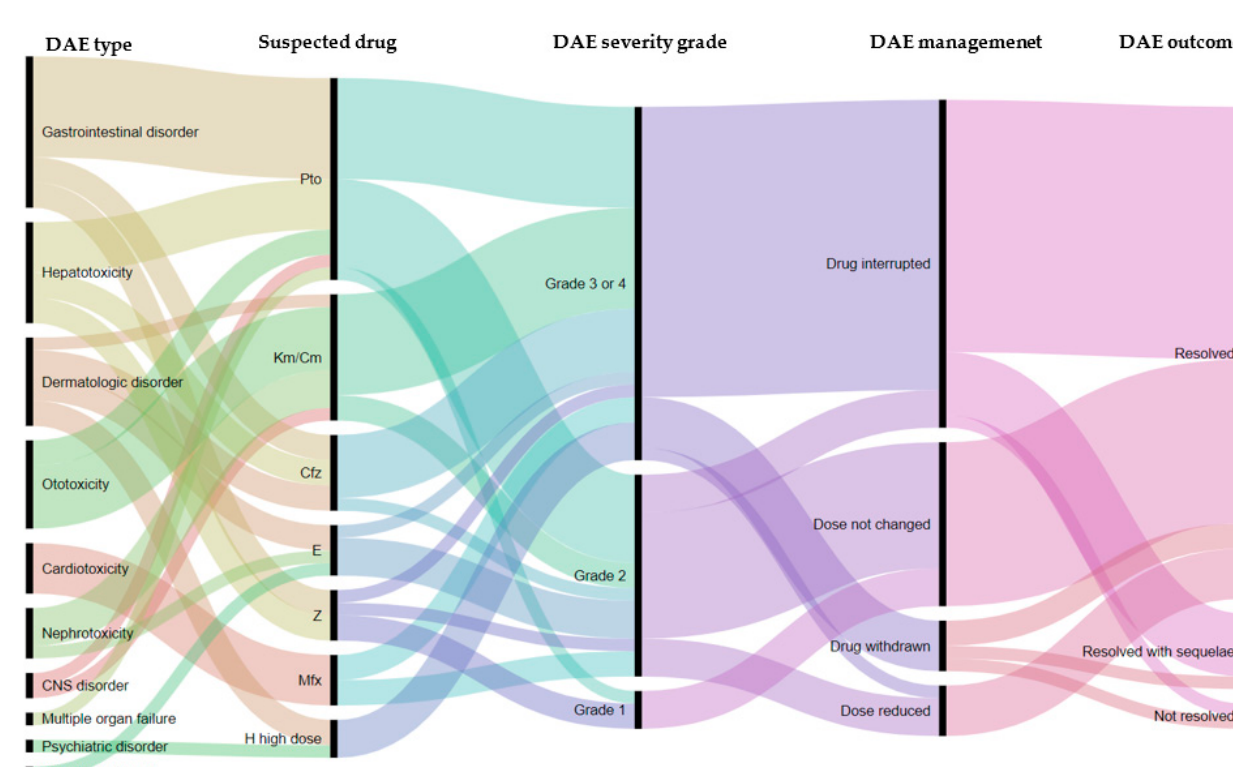
Figure 3. Alluvial plot illustrating the relationship between the types of adverse event, the suspected drug, the severity grade, the management and outcome of the adverse event among RR/MDR-TB patients on the shorter treatment regimen in Tashkent, Uzbekistan.